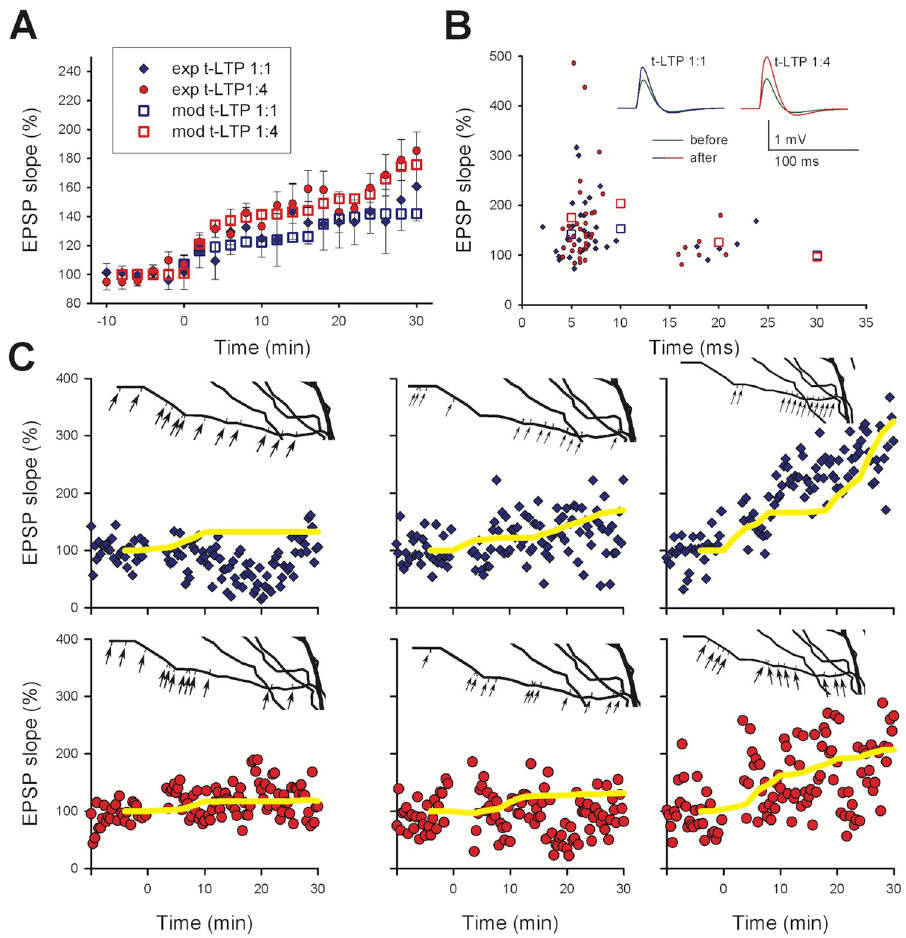
Fig 5. Comparison between model and experiments. A) Average EPSP slope, calculated from the 18 model synapses (red squares, using a Δ t = 5 ms) and experimental results after 70x 1:1 t-LTP (blue diamonds with error bars) or 25x 1:4 T-LTP (red circles with error bars) conditioning protocol. B) The final slope of simulated EPSPs (squares) for Δ t = 5 ms, 10 ms, 20 ms, and 30 ms are compared with experimental findings (circles). The inset shows typical model traces of EPSPs measured at the soma before (green) and after 1:1 t-LTP (blue) or 1:4 t-LTP (red). C) Experimental findings from individual neurons during 1:1 t-LTP (blue) or 1:4 t-LTP (red) compared with modeling results (yellow traces). In each panel, the inset shows the individual spines along the dendritic branch. The model parameters α AMPA and α RMpU were set to the following values to fit the experimental data. In the upper panels α RMpU = 0.9, 2.2, 7 (from left to right), in the lower panels α AMPA = 0.1, 0.5, 1.5 (from left to